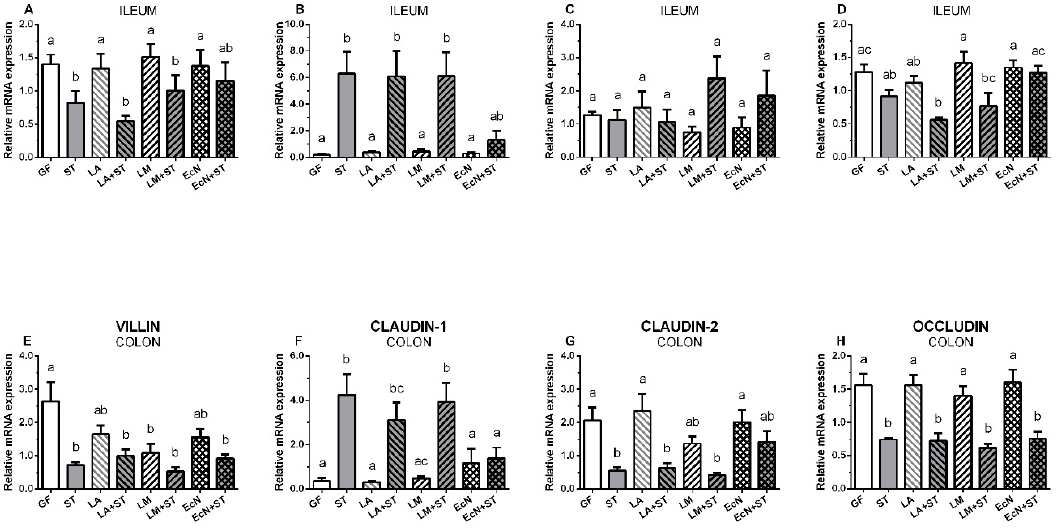
Figure 5. Transcriptions of villin, claudin-1, claudin-2, and occludin in the intestine of the gnotobiotic piglets. The relative mRNA expressions (fold change) were evaluated in the germ-free piglets (GF) and the piglets colonized / infected with L. amylovorus (LA and LA + ST), L. mucosae (LM and LM + ST), E. coli Nissle 1917 (EcN and EcN + ST), and S . Typhimurium (ST, LA + ST, LM + ST, and EcN + ST). Villin ( A , E ), claudin-1 ( B , F ), claudin-2 ( C , G ), and occludin ( D , H ) mRNA in the ileum ( A – D ) and colon ( E – H ) of the gnotobiotic piglets were normalized to β -actin and cyclophilin A. One-way analysis of variance (ANOVA) with Tukey’s multiple comparisons post-hoc test was used to compare di ff erences among the groups. The values are presented as mean + SEM. Statistical di ff erences P < 0.05 are denoted with di ff erent letters above the columns, and the same letter shown above the column indicates no statistically significant di ff erences. Six samples in each group were analyzed.